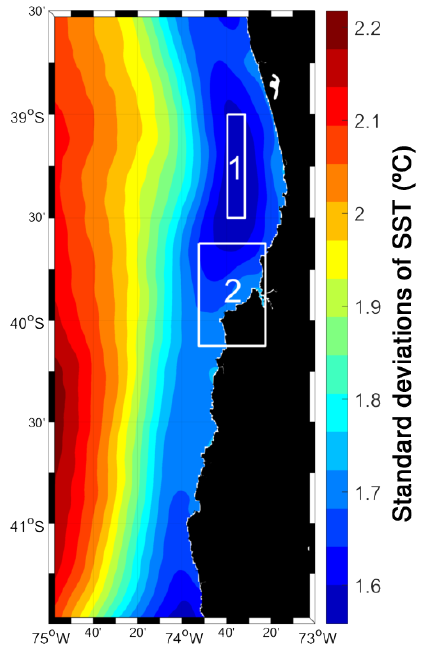
Figure 3. Standard deviations of all SST images. The white rectangle 1 was used as a reference for SST and chlorophyll-a concentration (Chl-a) averages and the white rectangle 2 was used as a reference for alongshore sea surface wind (SSW)